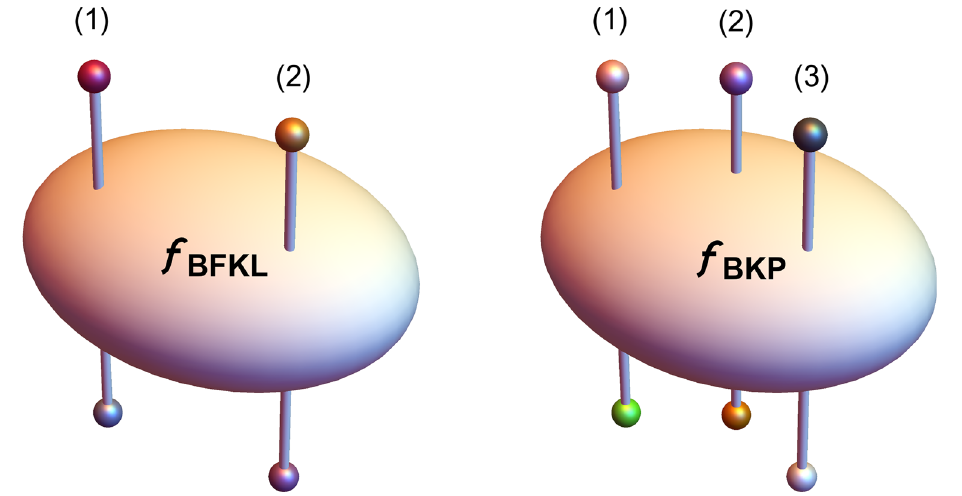
Fig. 1 Green functions describing the composite state of two (BFKL Pomeron) or three (BKP Odderon) reggeized-gluon composite